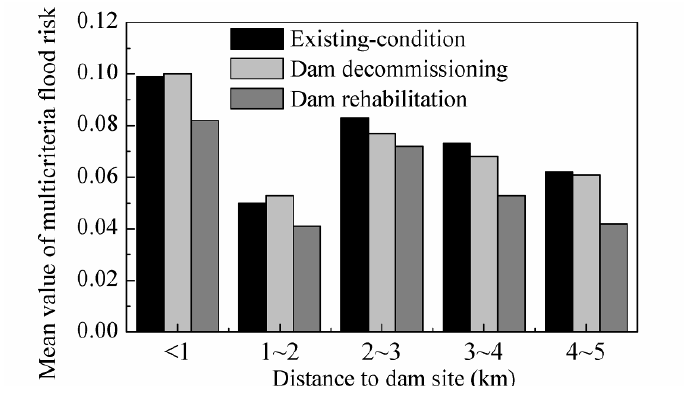
Figure 9. Comparison of multicriteria flood-risk averaged over different distances to the dam site among three